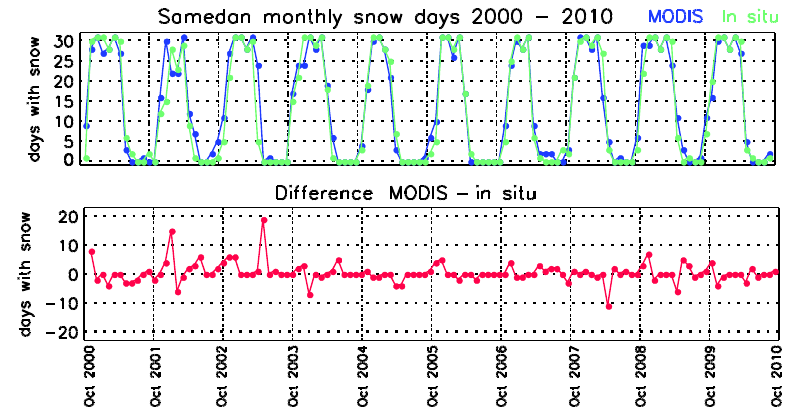
Fig. 3. Temporal variability of the monthly number of snow days and the differences (SCD MODIS − SCD in situ ) from 2000–2010 for Samedan. Table 4. Confusion matrix for SCD MODIS compared with in situ derived snow days (SCD in situ ) from 1 October 2000 to 30 September 2010 on a daily basis for all three